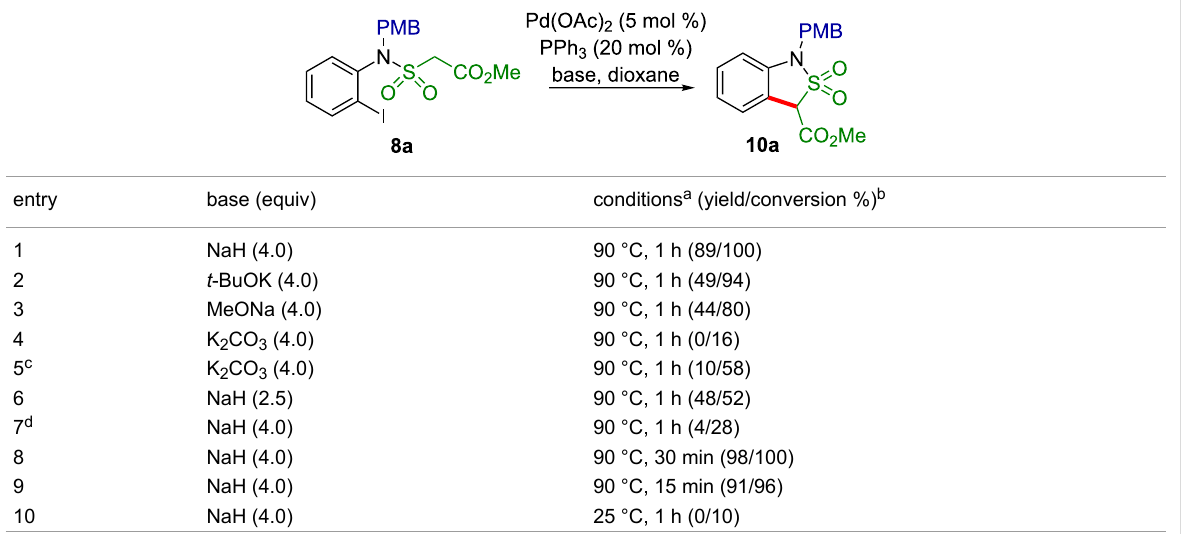
Table 1: Optimization of the reaction conditions for the Pd-catalyzed cyclization of the sulfonamide 8a .